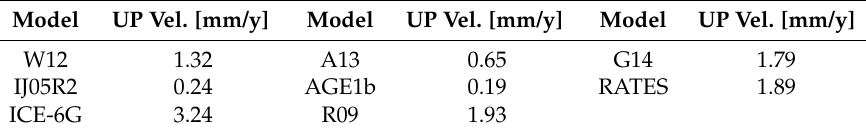
Table 8. Predicted vertical movement at Aboa from different GIA models